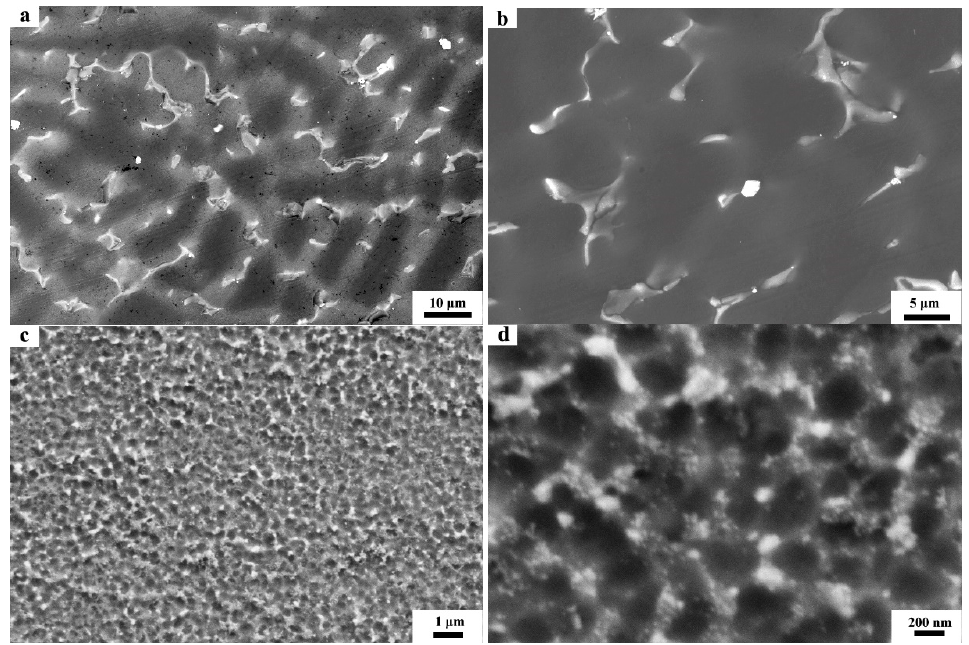
Figure 2. SEM images (secondary electron mode) of the as-cast and RS ribbon Mg 96.9 Gd 2.7 Zn 0.4 (at.%) alloy, ( a ) as-cast alloy with magnifying × 3000, ( b ) as-cast alloy with magnifying × 6000, ( c ) RS alloy with magnifying × 50,000, ( d ) RS alloy with magnifying ×